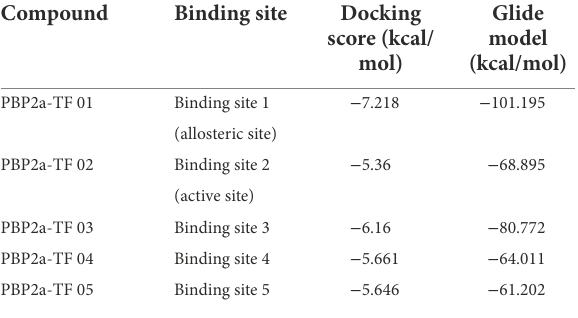
TABLE 1 Energy of conformer values of PBP2a-theaflavin (PBP2a-TF).